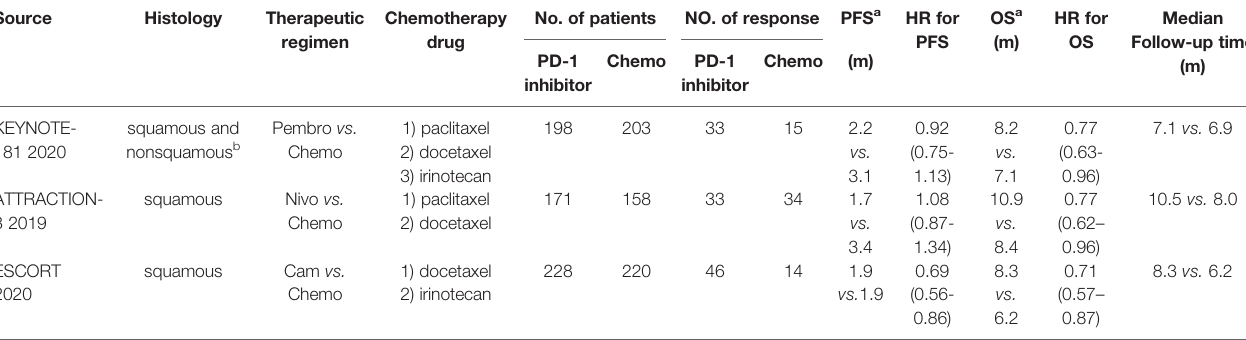
TABLE 1 | Principal features and outcomes in included trials comparing PD-1 inhibitor with